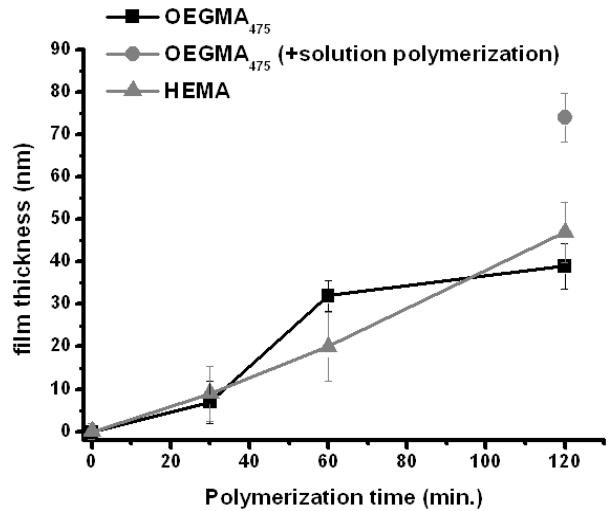
Figure 2. Layer-thickness evolution with increasing polymerization times.